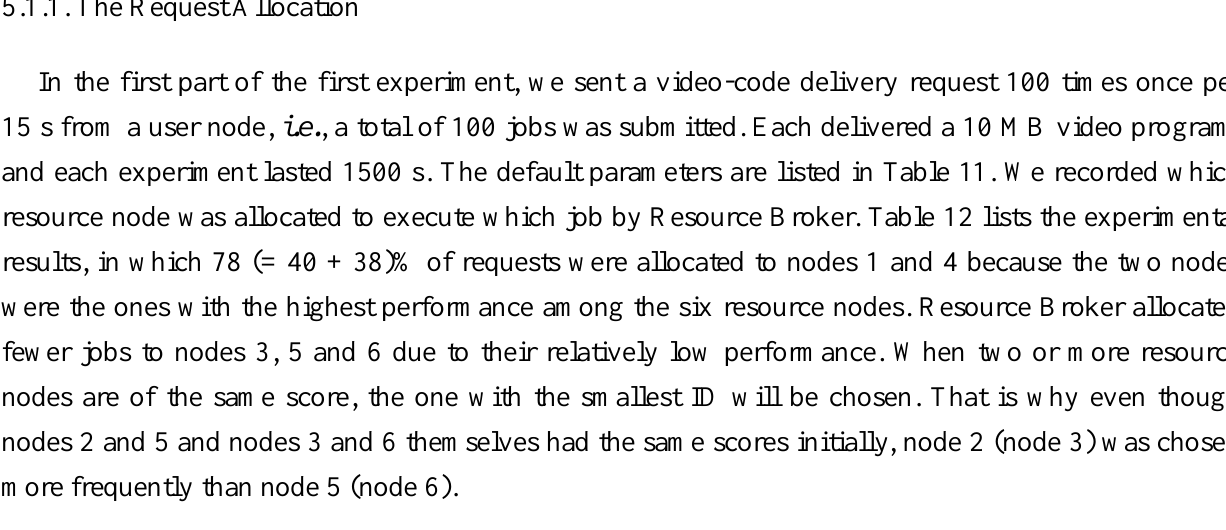
Table 13. Turnaround time of a